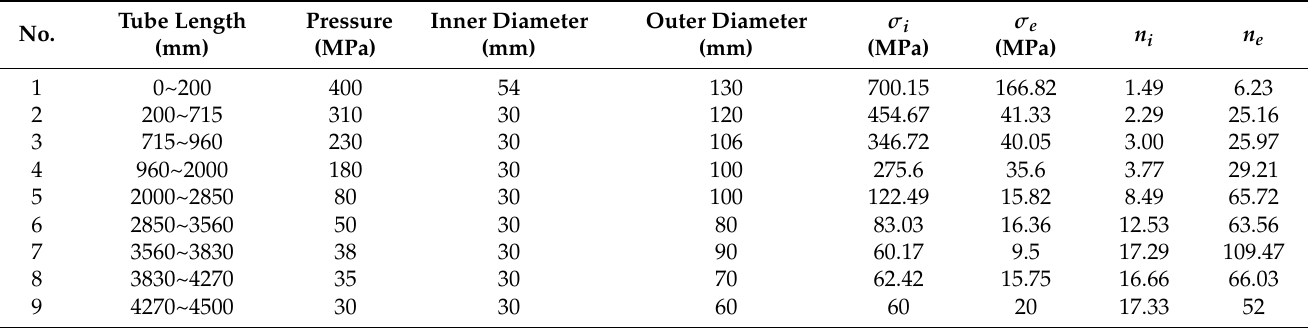
Table 1. Results of the tube strength.